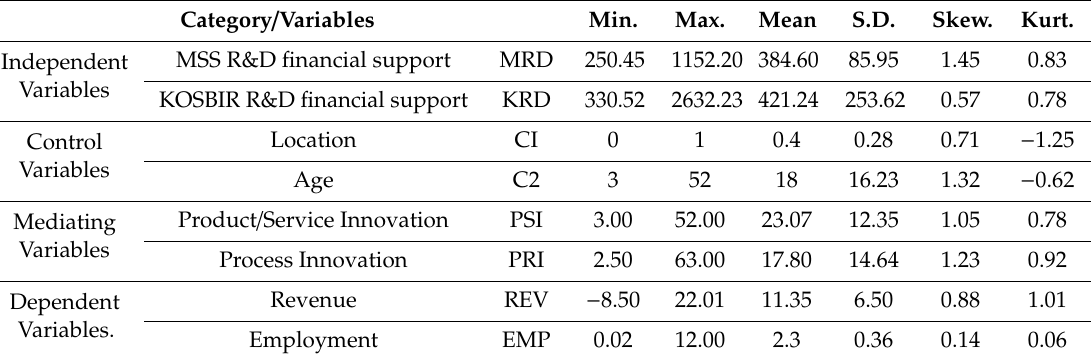
Table 2. Descriptive statistics for complete cases ( n =